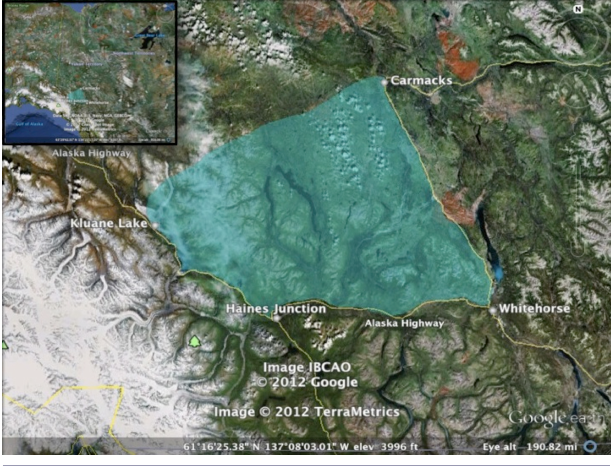
Fig. 1 . Study site. Southwest Yukon bounded by Whitehorse, Haines Junction, Kluane Lake, and Carmacks (Google Earth